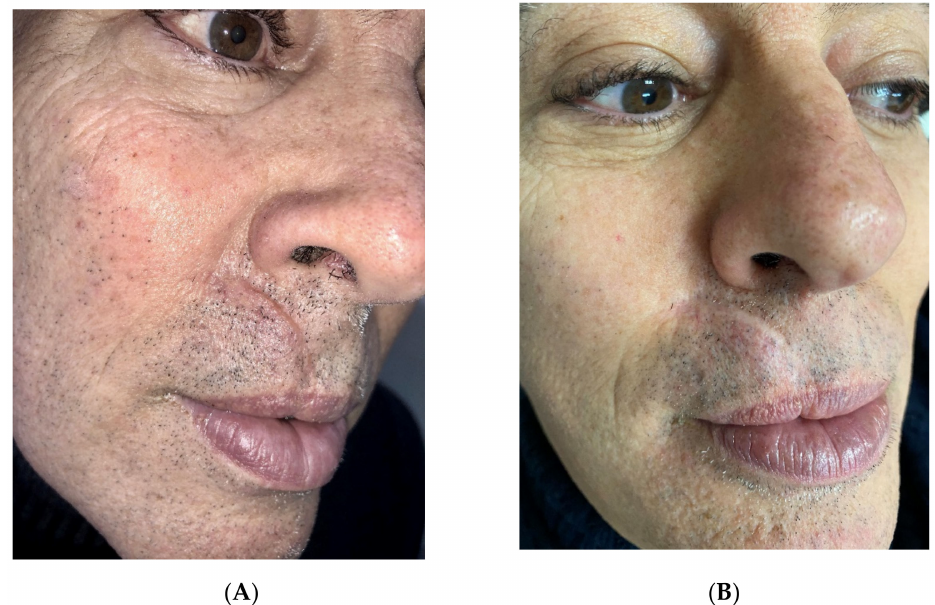
Figure 2. ( A ) Post traumatic hypertrophic scar. ( B ) After four sessions performed with LWP-RF device, with two sessions at 0,8 watt energy and 2Hz frequency, with no columns of sparing tissue, breaking down the thickening, and later with other two session at 0,6 watt energy and 3Hz frequency, with detached spots of sublimation to get the shrinkage, a reduction of thickness with a good settlement on the skin level, a reduction of erythema/pigmentation and a improvement of texture of the hypertrophic scar were observed.